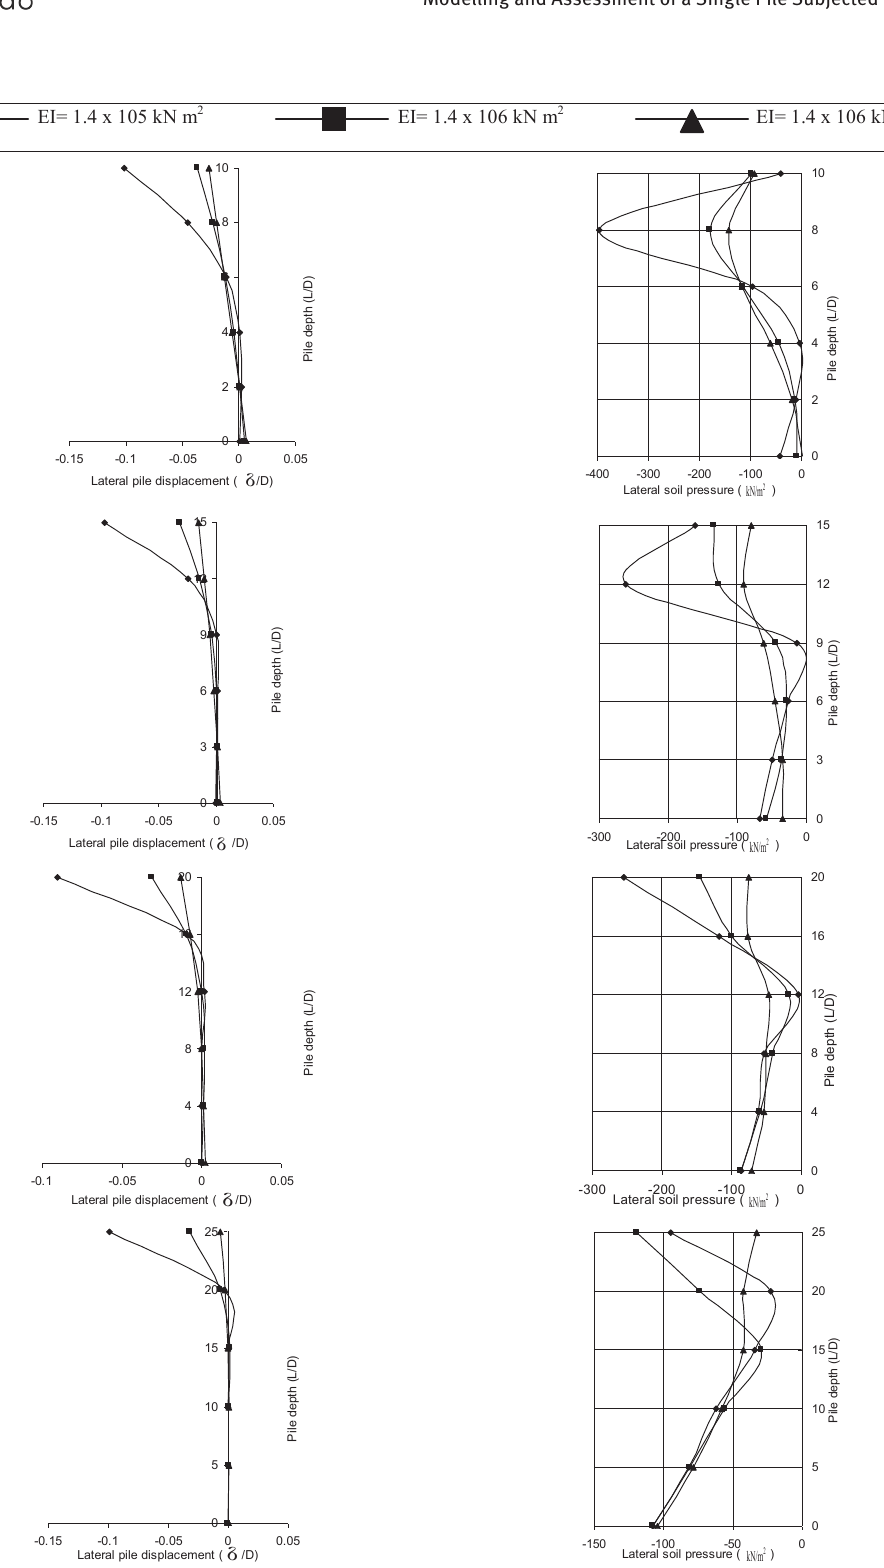
Figure 11 Influence of pile stiffness, EI , on the lateral soil pressure for cohesive soil, (a) L / D = 10, (b) L / D = 15, (c) L / D = 20 and (d) L / D = 25